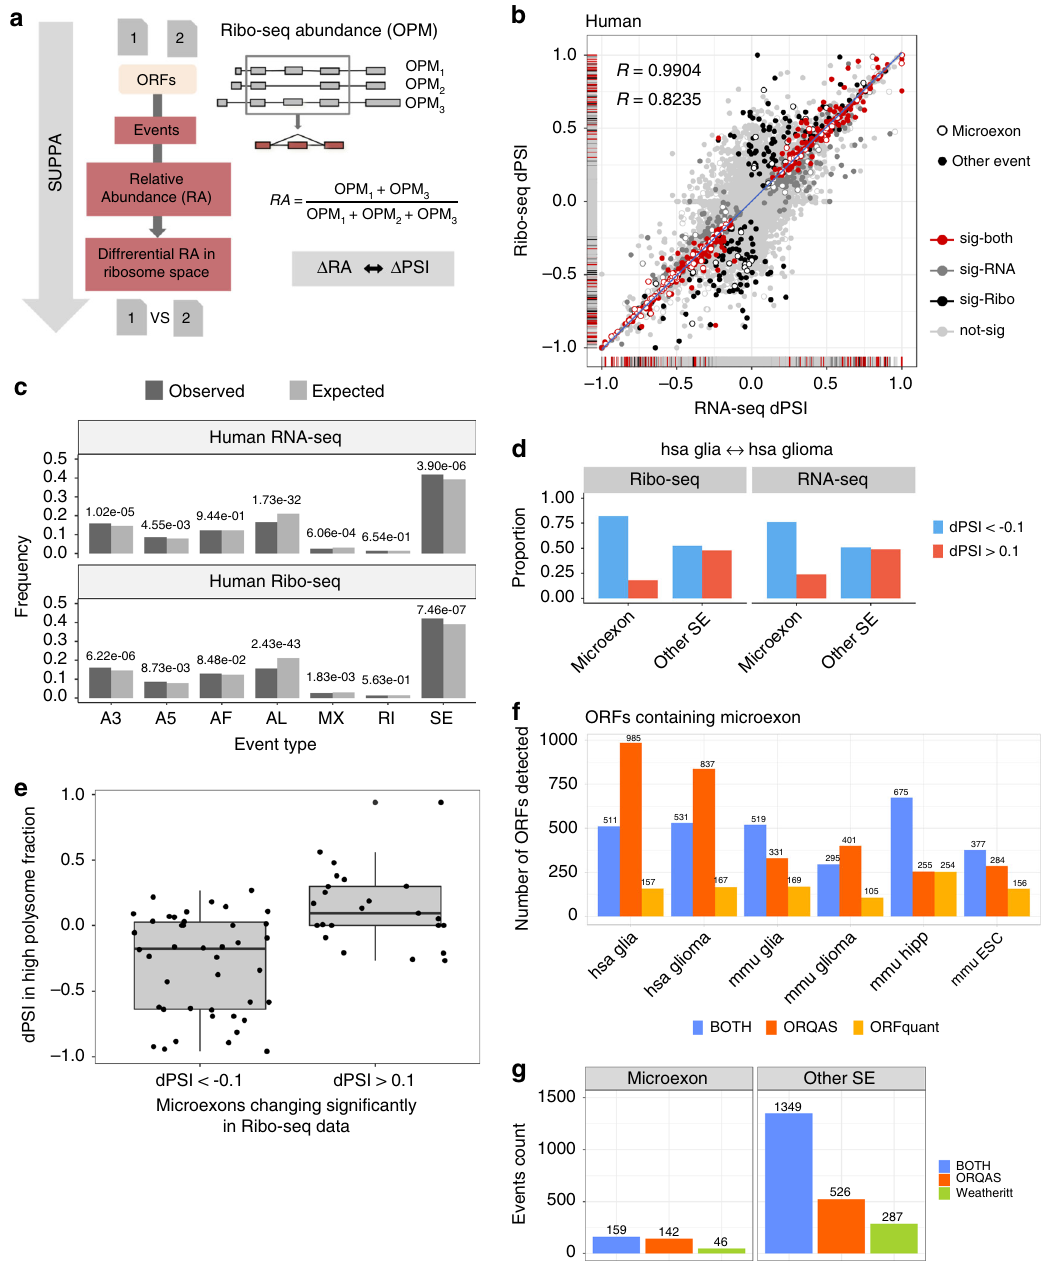
Fig. 4 Differential translation linked to differential splicing. a ORF abundances were used to calculate an event relative abundance (RA) with SUPPA. b Correlation of splicing and translation changes in events. In red, signi fi cant cases in ribosome and RNA space (363); in black (493) or dark gray (227), cases signi fi cant only in one comparison; in light gray, nonsigni fi cant cases. The bands show the density of cases along each axis. Empty circles indicate microexons. In blue, the correlation of the red points. In gray, the correlation of all other exons (black/dark gray/gray), both including microexons. c Differentially spliced events in RNA or ribosome space by event type: alternative 3 ′ ss/5 ′ ss (A3/A5), alternative fi rst/last exon (AF/AL), mutually exclusive (MX) exon, retained intron (RI), and skipping exon (SE). In light gray, the proportion of SUPPA events calculated from annotated coding regions in human. In dark gray, the proportion of events with signi fi cant change between glia and glioma. There is enrichment of SE events in RNA (Fisher ’ s p -value 3.90e – 06) and Ribo-seq (Fisher ’ s p -value 7.46e – 07), of A3 events in RNA (Fisher ’ s p -value = 1.02e – 05) and Ribo-seq (Fisher ’ s p -value 6.22e – 06), of A5 events in RNA (Fisher ’ s p -value 4.55e – 03) and Ribo-seq (Fisher ’ s p -value 8.73e – 03), and signi fi cant depletion of AL events in RNA (Fisher ’ s p -value 1.73e − 32) and Ribo-seq (Fisher ’ s p -value 2.43e − 43) and of MX events in RNA (Fisher ’ s p -value 6.06e – 04) and Ribo-seq (Fisher ’ s p -value 1.83e – 03). d Enrichment of microexons with an impact on RNA splicing and ORF translation in glia vs glioma. dPSI denotes the difference in relative abundance in RNA or ribosome spaces. e dPSI values for high polysome fraction between neuronal samples and ESCs ( y -axis) for microexons with signi fi cant change in ribosome space ( x -axis). Box boundaries correspond to the fi rst and third quartiles, the thick black line indicates the median, and top and bottom lines indicate the maximum and minimum values. Black dots represent all data points. f ORFs containing microexons detected only by ORQAS (orange), ORFquant (yellow), or both (blue). g Microexons (<52nt) and other SE events detected in ribosome space with PSI > 0.1 only by ORQAS (orange), by analyses from ref. 31 (green), or by both methods